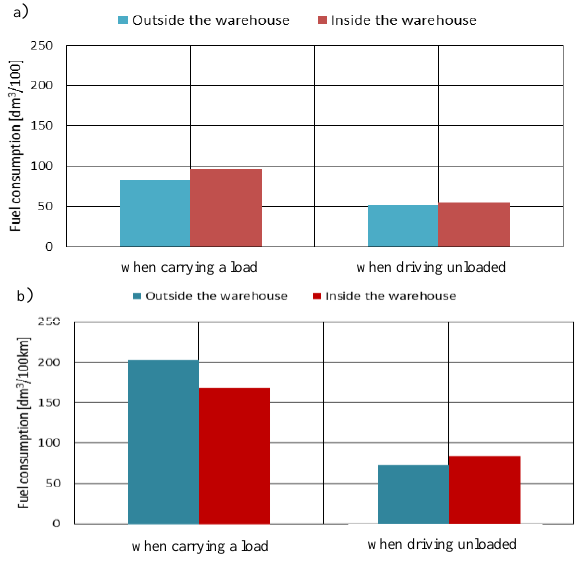
Fig. 12. Average specific fuel consumption, a) compression ignition engine vehicle, b) LPG